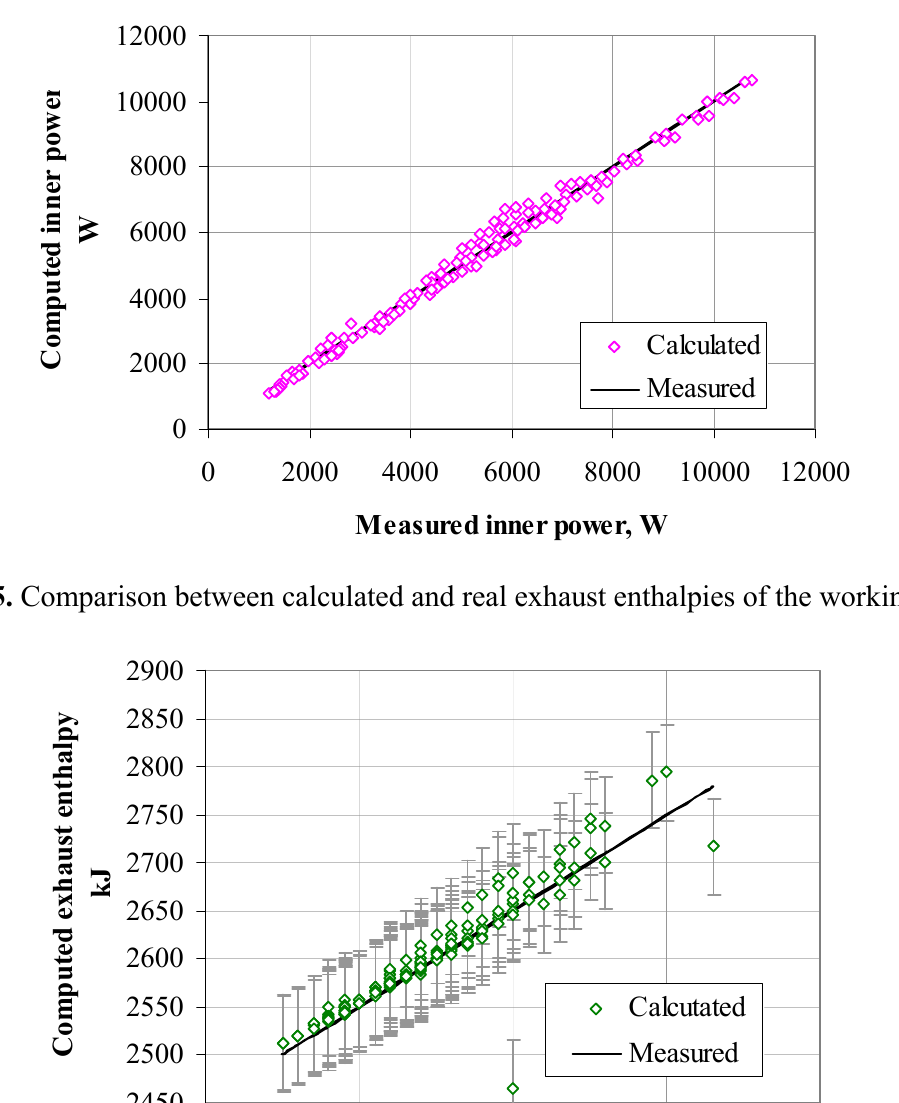
Figure 4. Comparison between calculated and measured internal power outputs of the expander.